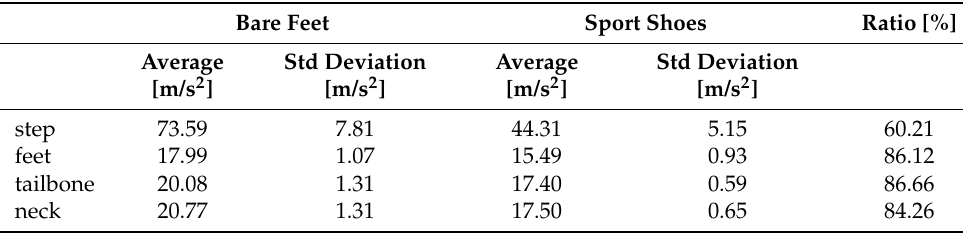
Table 4. Ratios of the top acceleration damping between bare feet and sport